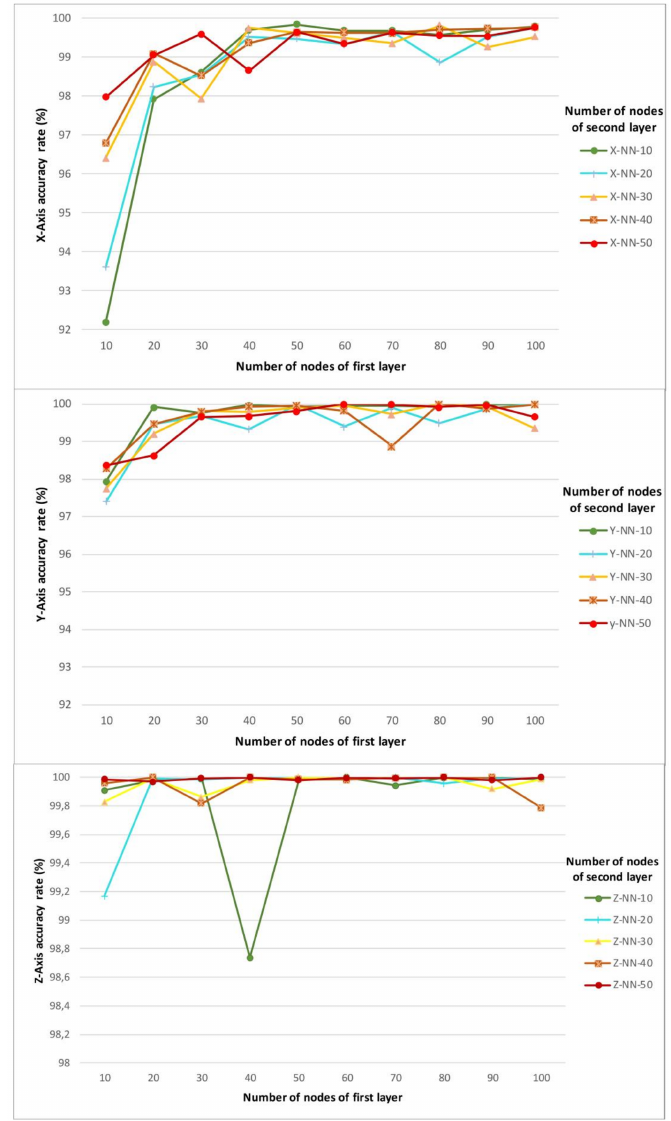
Figure 9. Accuracy rates (%) for each neural